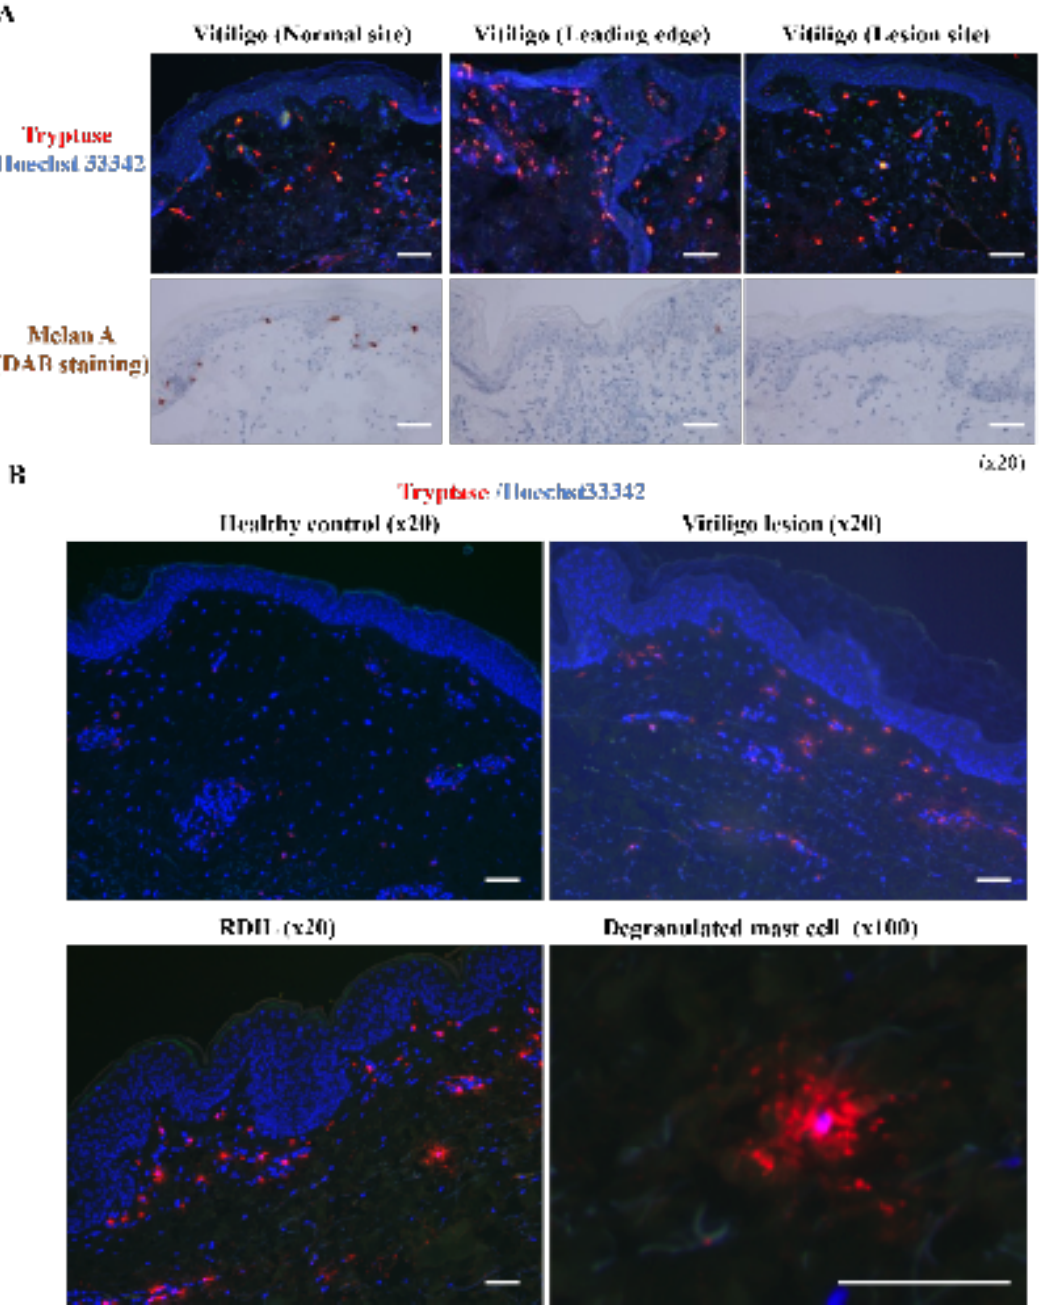
Figure 2. Degranulated mast cell numbers are increased in vitiligo and RDIL. Skin biopsies were taken from the edge of vitiligo lesion, and then cut into three portions including normal site, leading edge, and lesion site. These skin sections were stained with anti-tryptase in red, and consecutive sections were stained with anti-Melan A by 3,3’-Diaminobenzidine (DAB) staining (A). After staining with anti-tryptase in red, the degranulation of mast cells was examined in skin sections of healthy control, vitiligo and RDIL (B). Scale bar: 100